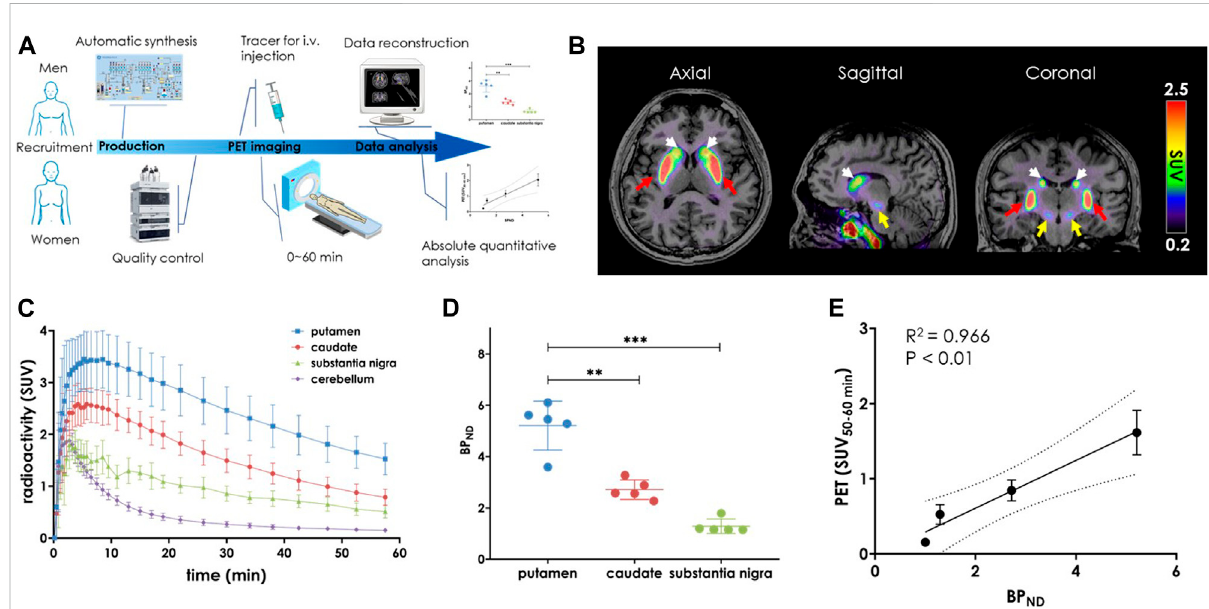
FIGURE 4 PET-MRI study of [ 18 F] 3 in the living human brain. (A) General fl ow chart of the experiment including four parts: volunteer recruitment, radioligand production, PET imaging and data processing; (B) Averaged PET-MRI images (0 – 60 min) presented in the axial, sagittal and coronal views. The layers showed high uptake of the putamen (red), caudate (white) and substantia nigra (yellow). The color scale on the right side of the picture is in SUV units; (C) Time activity curves (TACs) of PET imaging after injection of [ 18 F] 3 ( n = 8); (D) BP ND values in putamen, caudate and substantia nigra. Data are presented as mean ± SD ( n = 8). Asterisks indicated statistical signi fi cance, **** p < 0.0001; (E) Correlation analysis of BP ND with SUV (50 – 60 min) ( R 2 = 0.966, p <